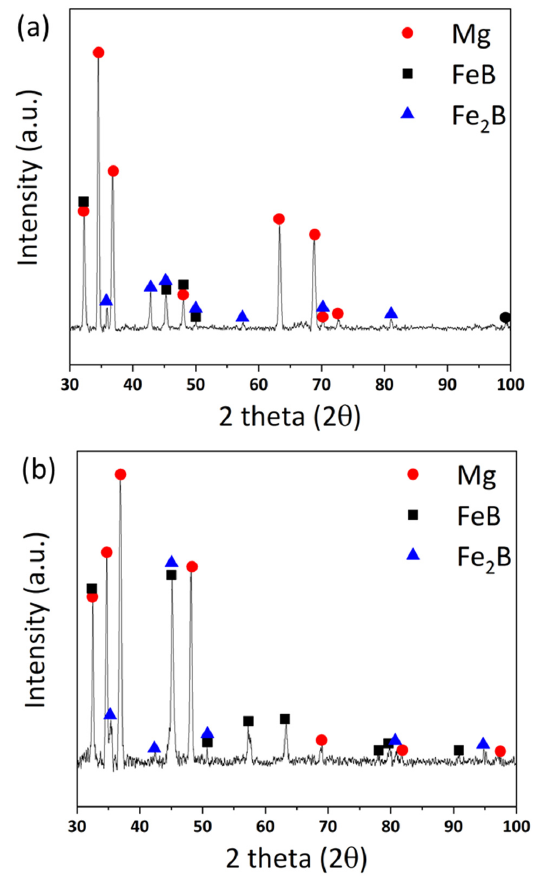
Figure 4. Phase analysis with point XRD in ( a ) light gray phase-dominated zone, as (1) in Figure 3, and ( b ) dark gray phase-dominated zone, as (2) in Figure 3.